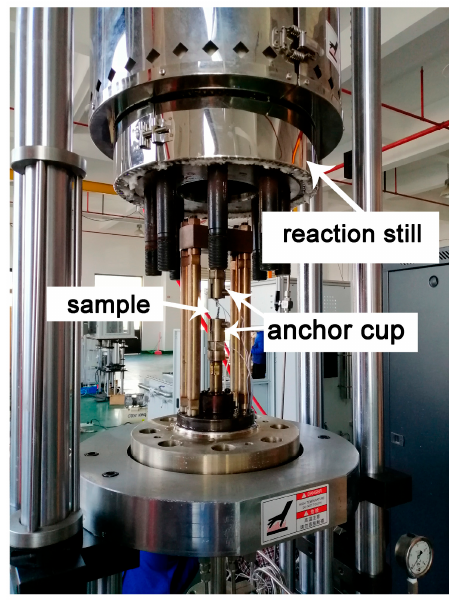
Figure 4. Corrosion fatigue testing machine.